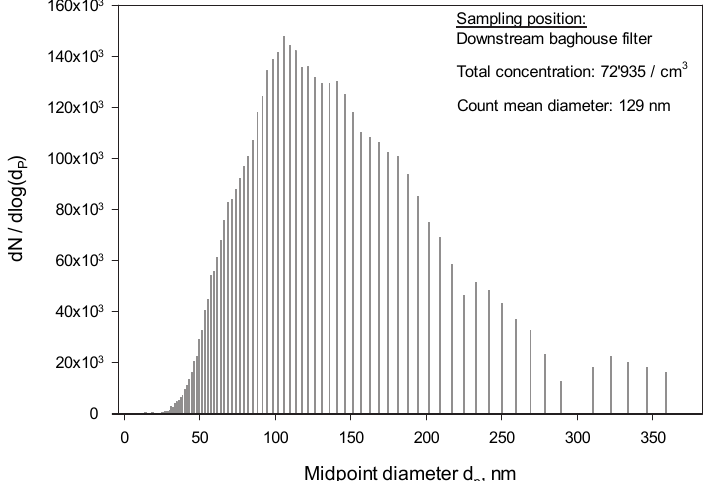
Fig. 5 Particle size distribution measured by a scanning mobility particle sizer in the off-gas downstream of the baghouse filter during production of FePO nanoparticles with 20 nm primary particle diameter. The total concentration was 4 approx. 73,000 / cm 3